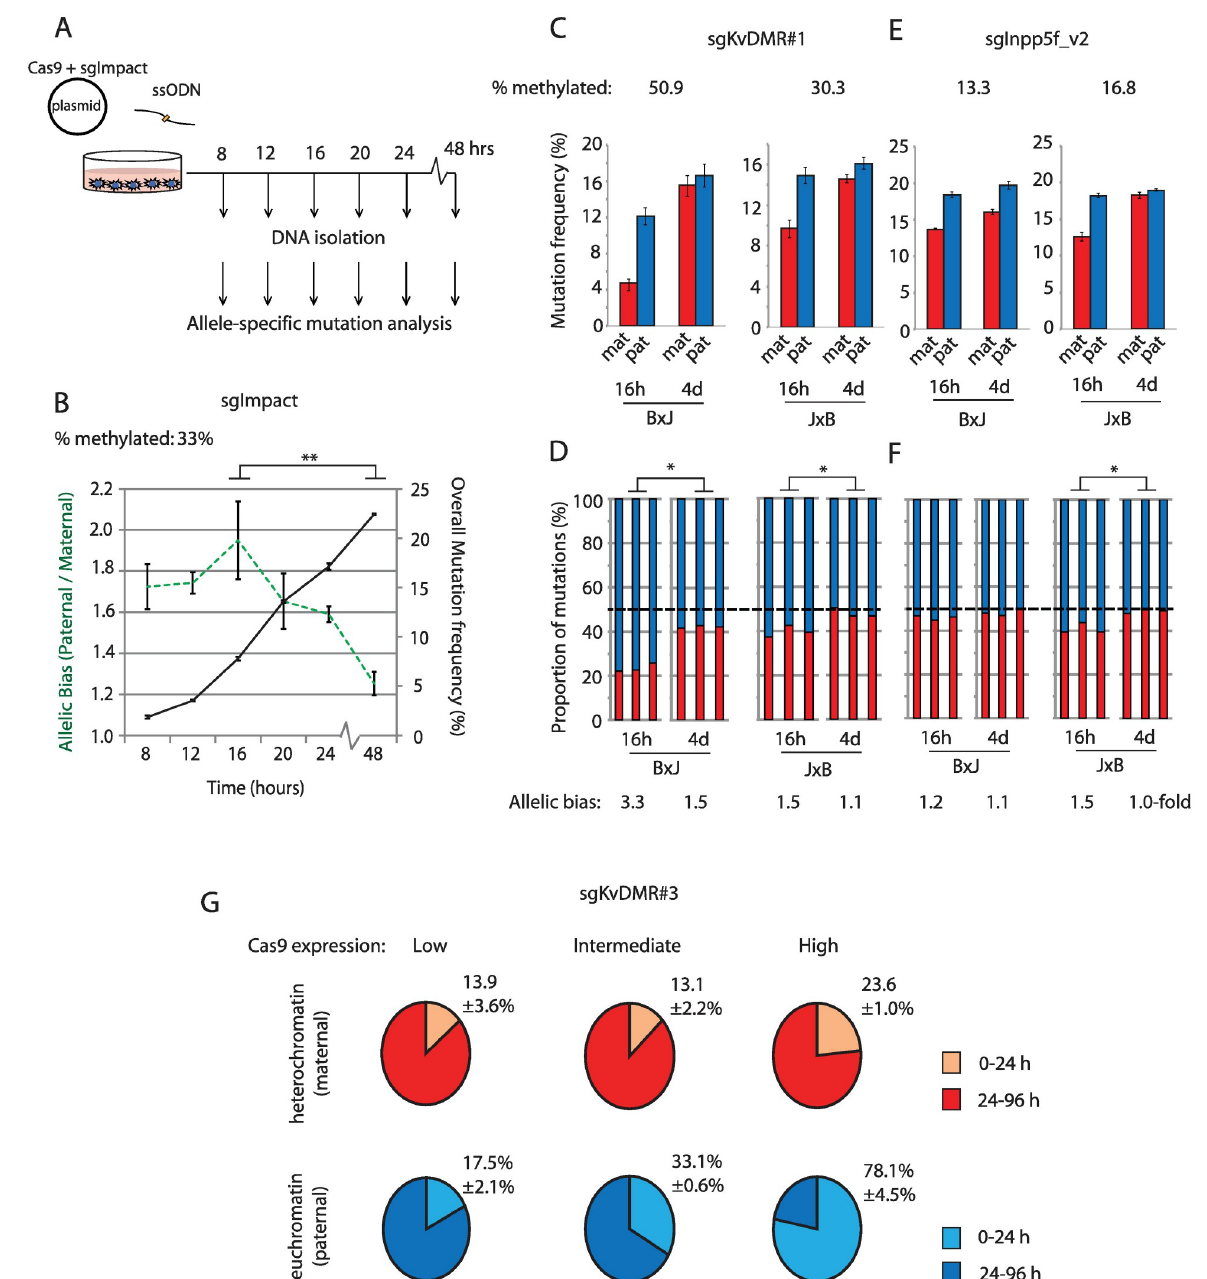
Fig 5. Heterochromatin impairs the kinetics of CRISPR mutagenesis. Schematic depicting the experimental workflow for the time course experiment in panel B. (B) Overlaid line graphs depict total mutation rates (black solid line, right y-axis) and fold-enrichment for mutations on the euchromatic paternal allele (green dashed line, left y-axis) over time using sgImpact targeting the imprinted Impact locus (S2 Fig) in B × J cells. Error bars represent SD of three biological replicates. Transfected cells were not selected in this experiment. (C, E) Allele-specific mutation frequencies at 16 and 96 hours post transfection for experiments using an sgRNA targeting KvDMR (sgKvDMR#1; S1A Fig). Error bars represent SD ( n = 3). (D, F) Stacked histograms show the allelic mutation bias in each experiment. Asterisks denote p -values for unpaired t tests on the fold-difference between maternal and paternal allele mutation frequencies following brief (16-hour) compared to long (4-day) exposure high-passage cells. ��� p < 0.001. (G) Pie charts show mutation frequencies observed 24 hours post transfection, expressed as a percentage of the mutation frequency in cells collected after 96 hours. Data are derived from the experiment described in Fig 4 and S4 Fig, with mutation frequencies broken down by both parental allele and Cas9 expression level. Experiments used sgKvDMR#3 in B × J cells collected either immediately after sorting on Cas9-2A-eGFP (24 hours) or after an additional 72 hours in culture. CIs indicate SD ( n = 3 biological replicate transfections). Quantitative data underlying all panels are provided in S1 Data, and details of MiSeq libraries including SRA accessions are provided in S2 Data. Cas9, CRISPR-associated protein 9; eGFP, enhanced green fluorescent protein; sgRNA, single guide RNA; SRA, Sequence Read Archive; ssODN, single-stranded oligodeoxynucleotide.